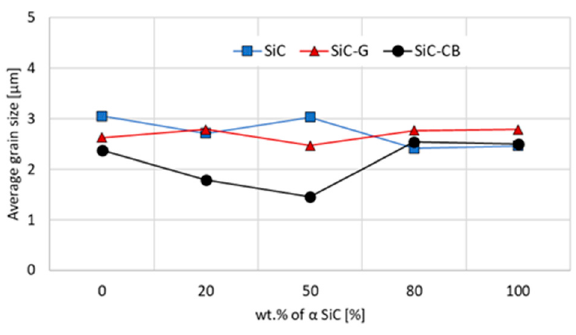
Figure 6. Average grain size of SiC sinters.